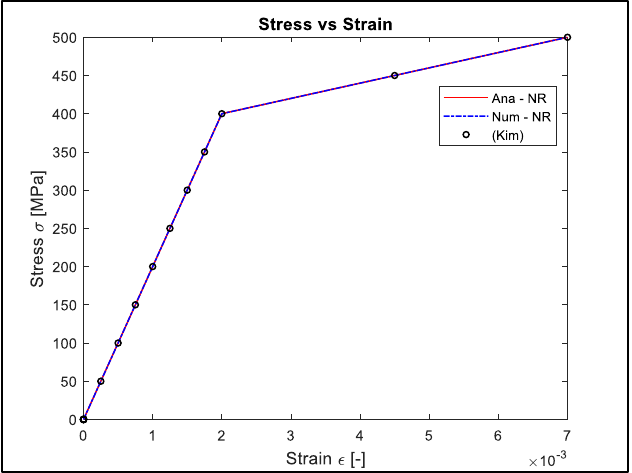
Figure 6. Stress-strain for a single element considered for 𝜔 = 10 −6 and 𝑡𝑜𝑙 = 10 −6 .